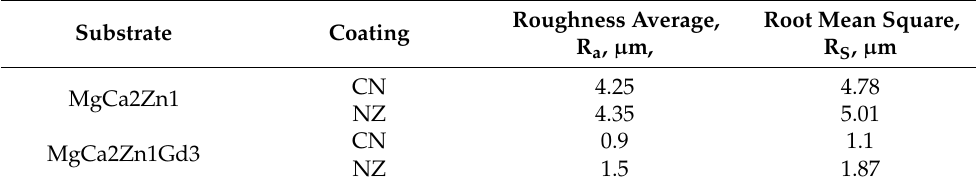
Figure 4. Confocal images of conversion coatings surface topography deposited on MgCa2Zn1 alloy: ( a ) casein coating (CN); ( b ) casein-free coating (NZ), and MgCa2Zn1Gd3 alloy: ( c ) casein coating (CN); ( d ) casein-free coating (NZ). Table 1. Surface roughness parameters of the conversion coatings on MgCa2Zn1 and MgCa2Zn1Gd3 alloys.